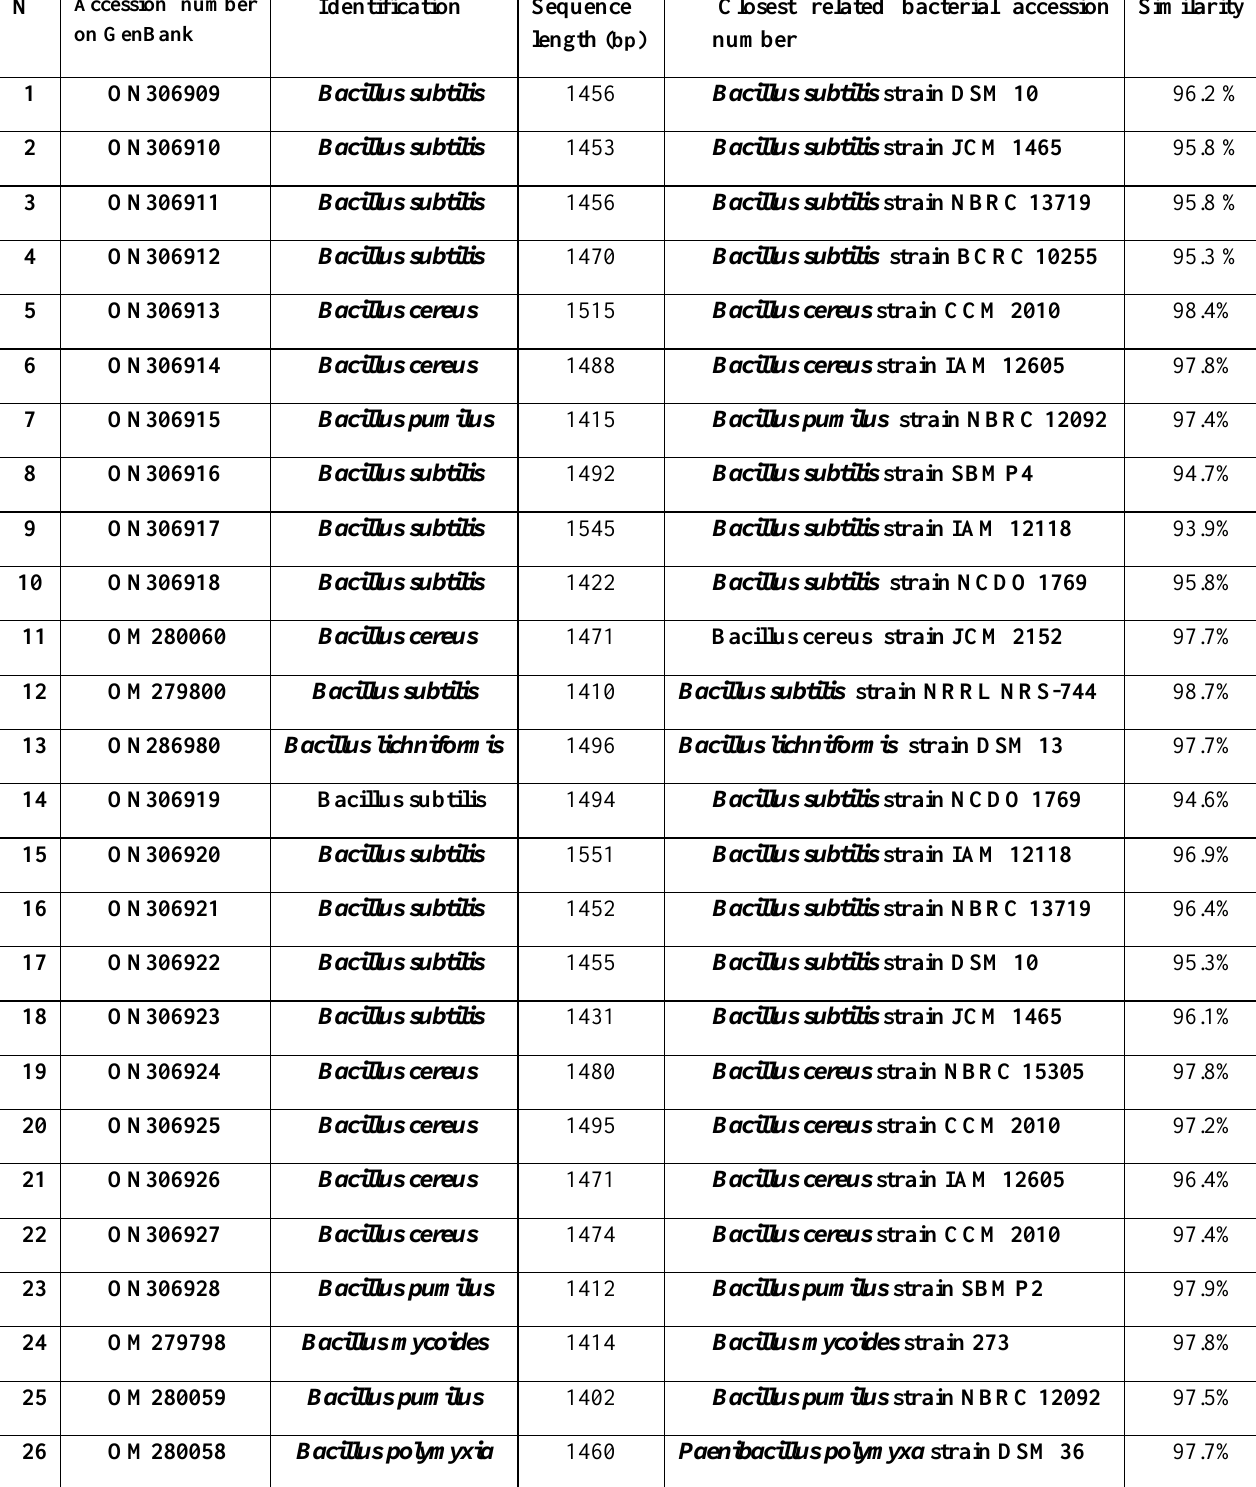
Table 2. Molecular characterization of selected Bacillus